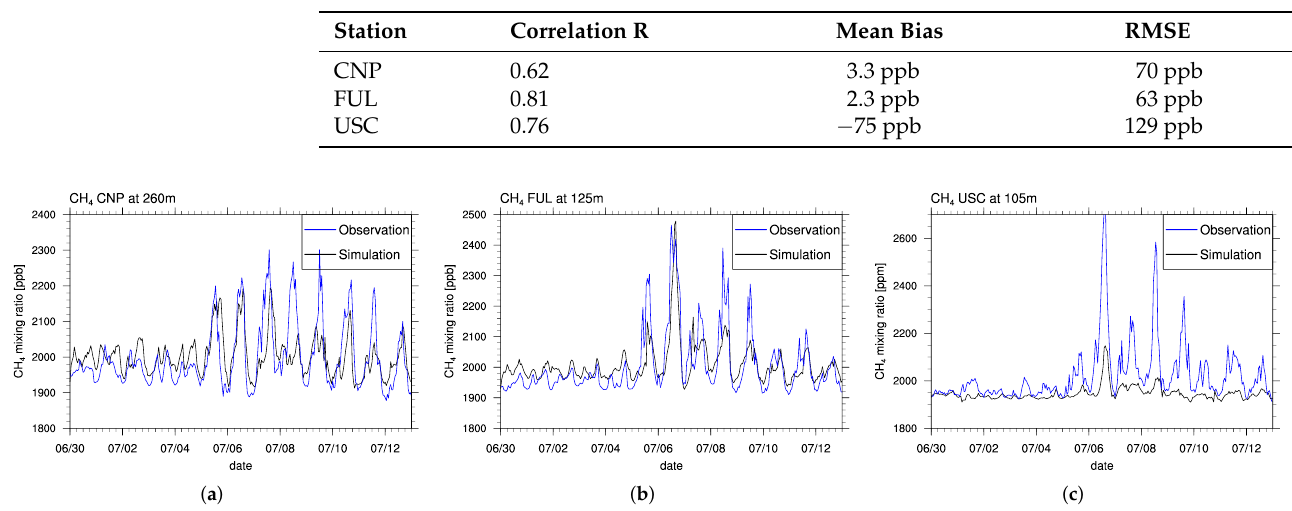
Table 5. Statistics of observed and simulated methane concentrations from 30 June–13 July 2018.